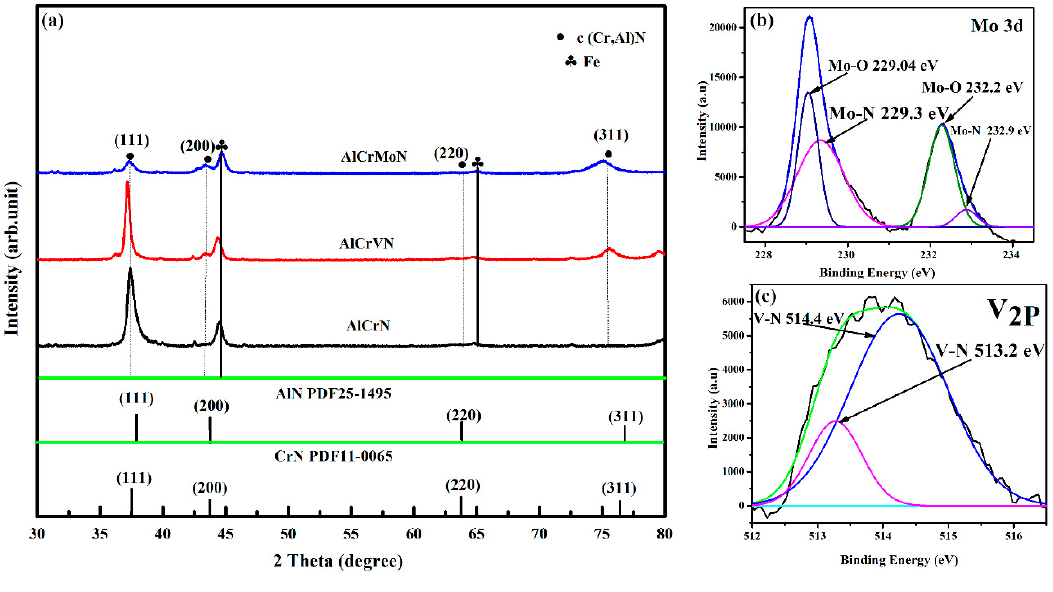
Figure 2. ( a ) X-ray diffraction (XRD) spectrum of the three coatings coated HSS substrates and XP-spectrum of ( b ) AlCrMoN coating coated HSS substrates, ( c ) AlCrVN coating coated HSS substrates.